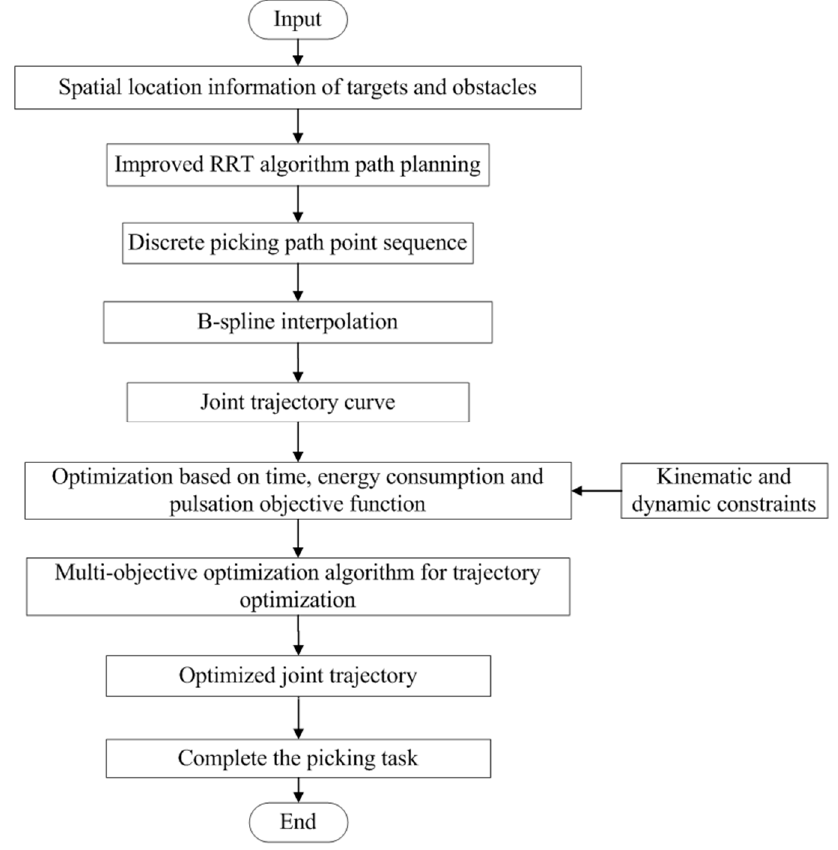
Figure 13. Workflow of manipulator motion planning.